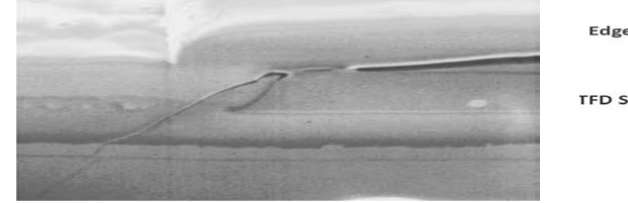
Figure 11. Delamination at die edge after 168 hours of steam [33]. (Courtesy : C. Hong, Intel).